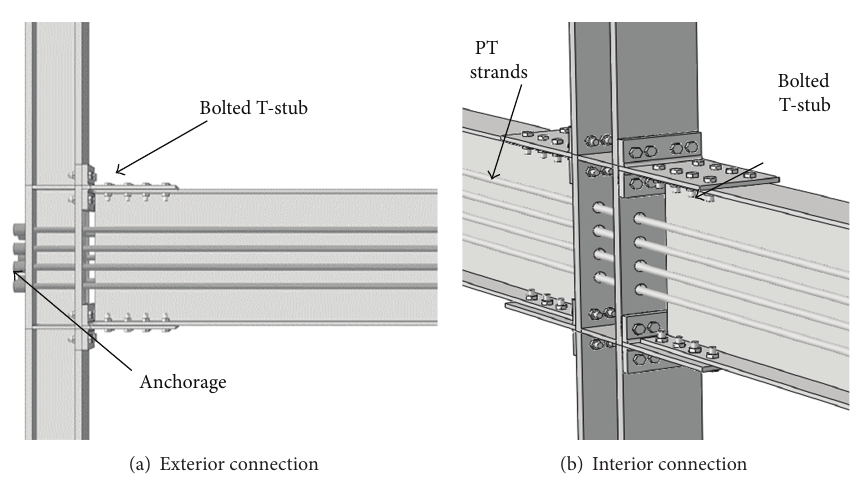
Figure 2: Connection